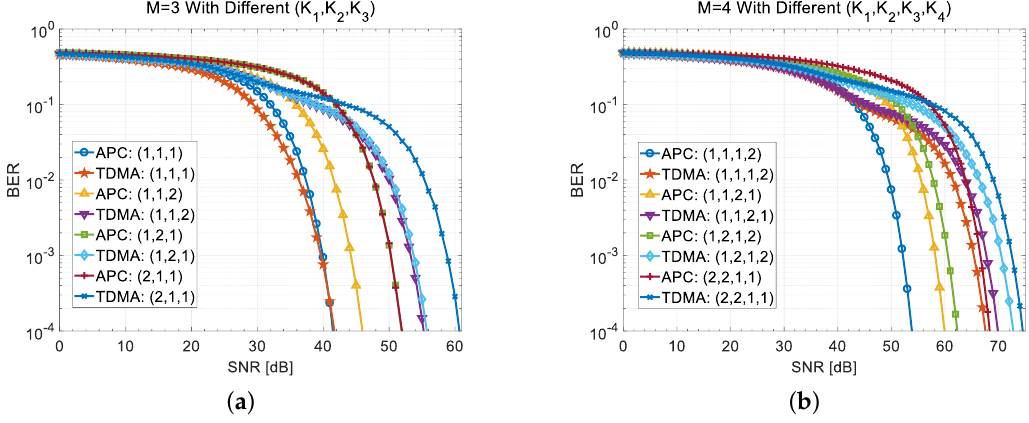
Figure 3. ( a ) Three users’ BER performance comparisons of our proposed APC and TDMA for different p K 1 , K 2 , K 3 q ; ( b ) Four users’ BER performance comparisons of our proposed APC and TDMA for different p K 1 , K 2 , K 3 , K 4 q